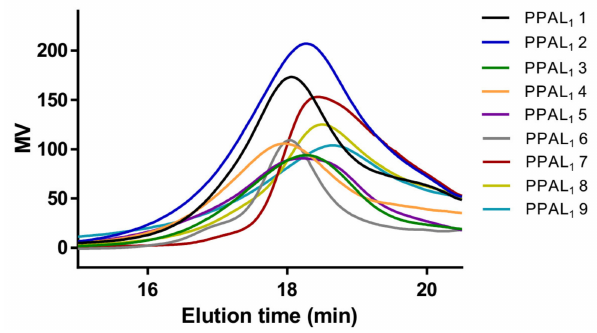
Figure 3. GPC curve of PPAL 1 1–9 copolymers in THF.